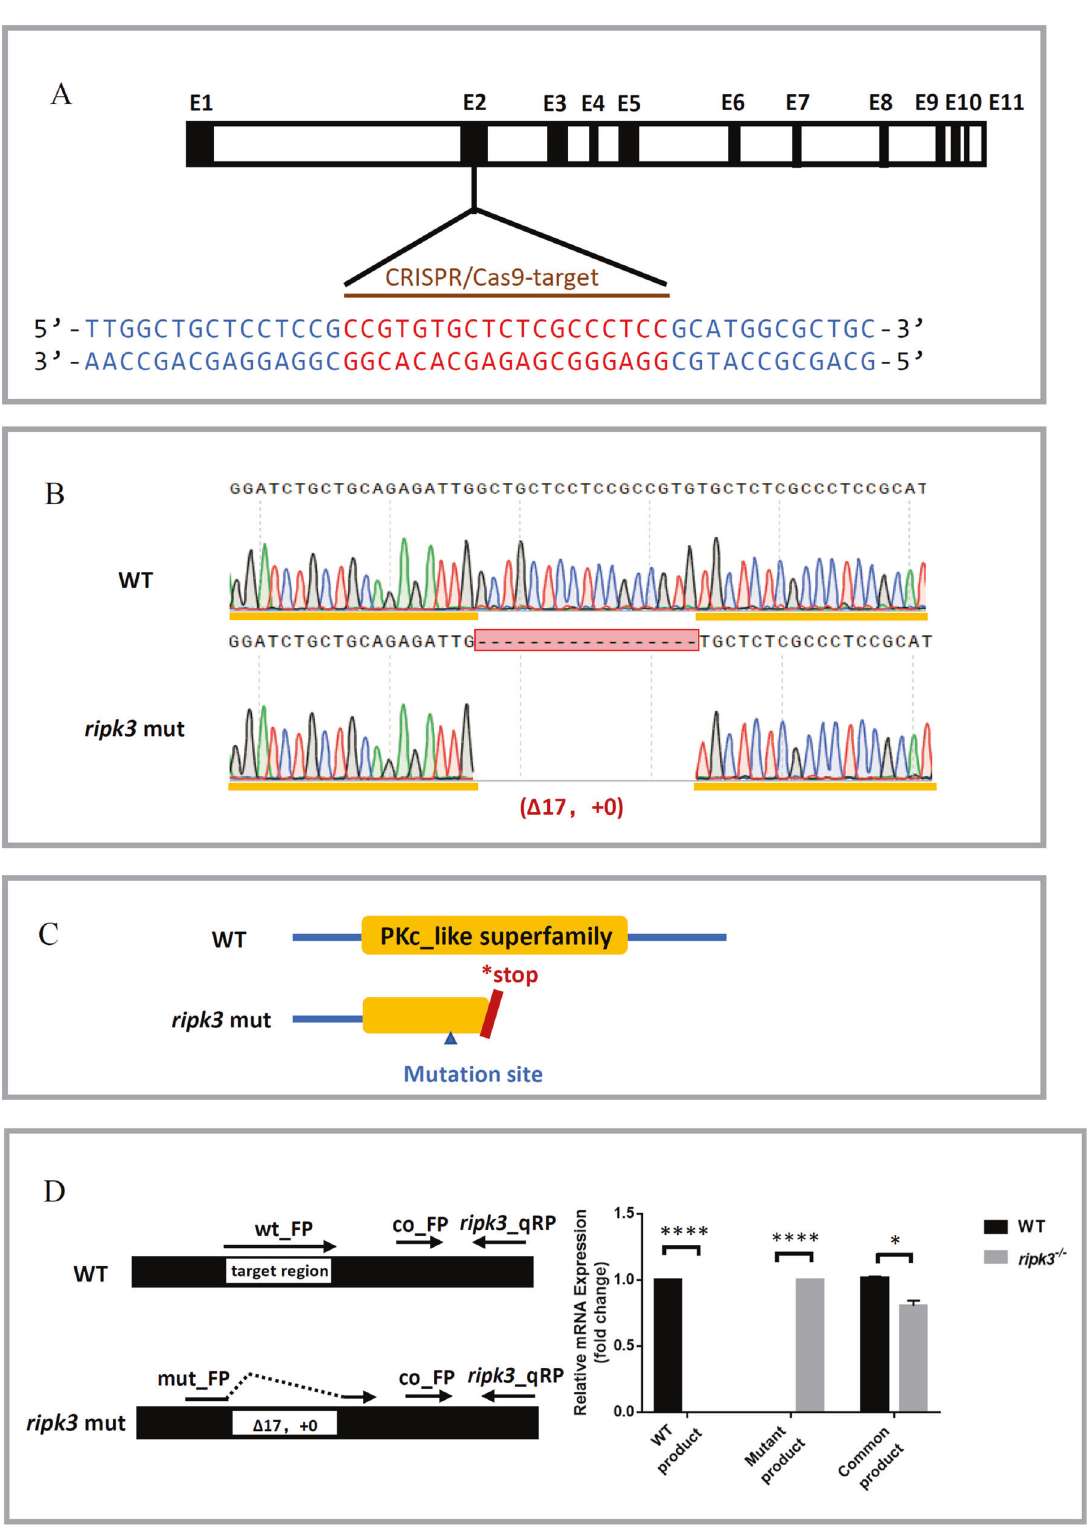
Fig. 1 Generation of the ripk3 knockout zebra fi sh line. A CRISPR target of ripk3 . The CRISPR/Cas9 target sequence was designed on the second exon of ripk3, and mutations were created using CRISPR-Cas9 technology. B Mutation form of ripk3 -de fi cient larvae. A mutation strain with 17 bp deletion in the ripk3 gene ( − 17 bp, + 0) was applied in this study. C Protein changes upon ripk3 mutation. In the ripk3 -de fi cient larvae, a premature stop codon was generated and disrupted the PKc_like superfamily protein domain. D Validations of the ripk3 mutation. Q-PCR revealed that the WT or mutant product of ripk3 mRNA could only be detected in the WT or ripk3 -de fi cient larvae, respectively. The expression of the common product showed that ripk3 was signi fi cantly lower expressed in the ripk3 -de fi cient larvae ( n ≥ 10, Student ’ s t -test).